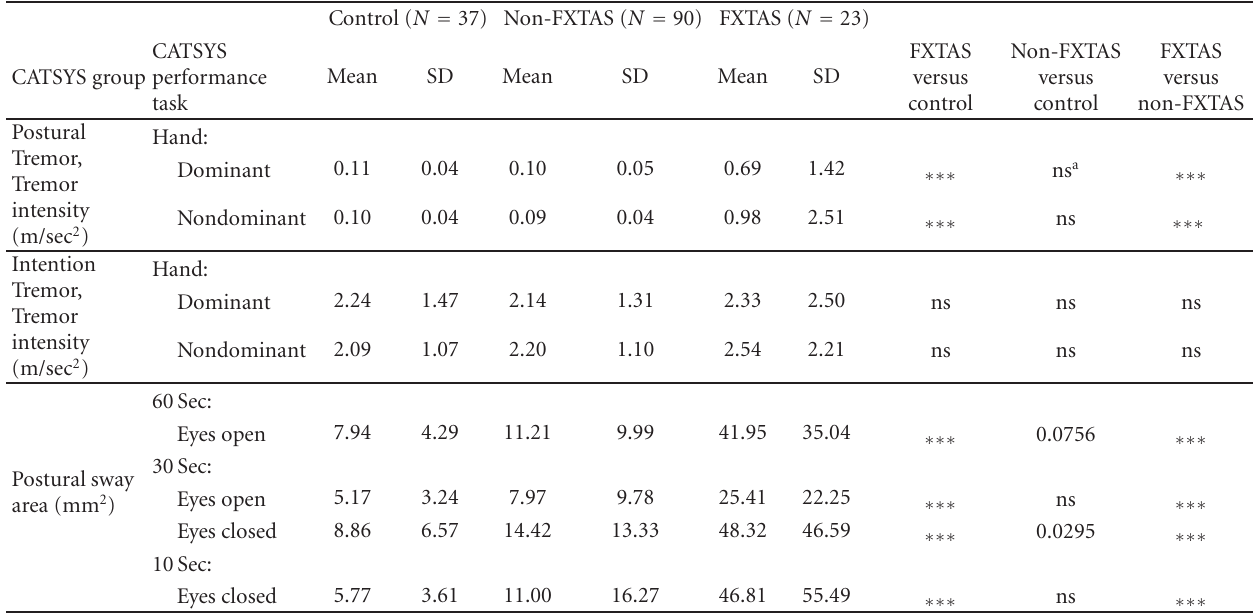
Table 2: Comparison of a priori primary outcome CATSYS measures.